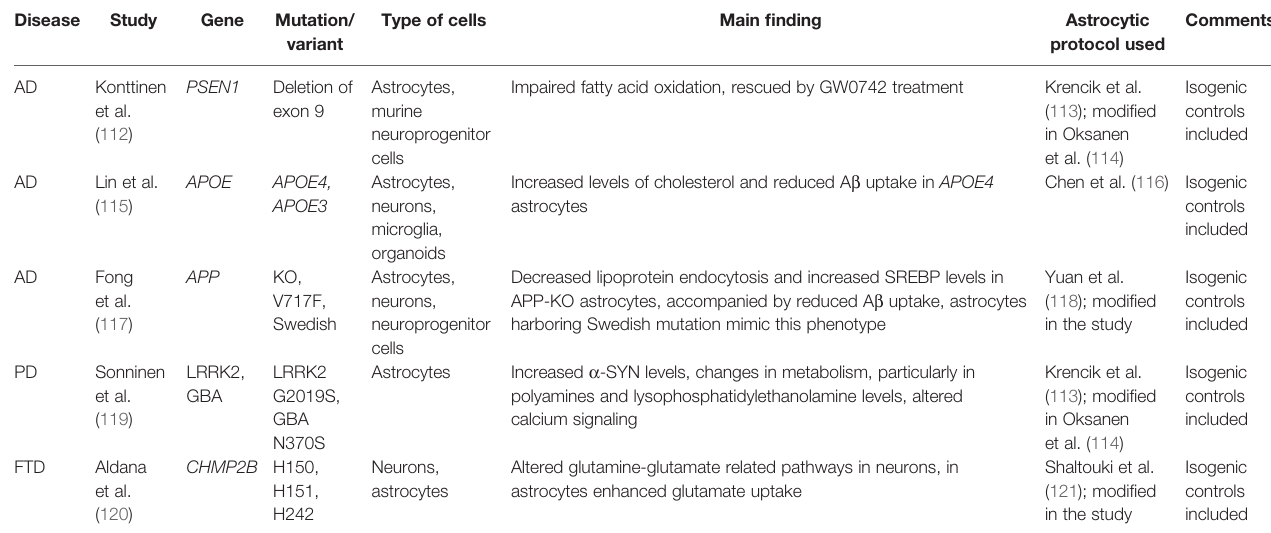
TABLE 1 | The summary of patient-derived models used to elucidate the effects of neurodegeneration-linked mutations on astrocytic metabolism.